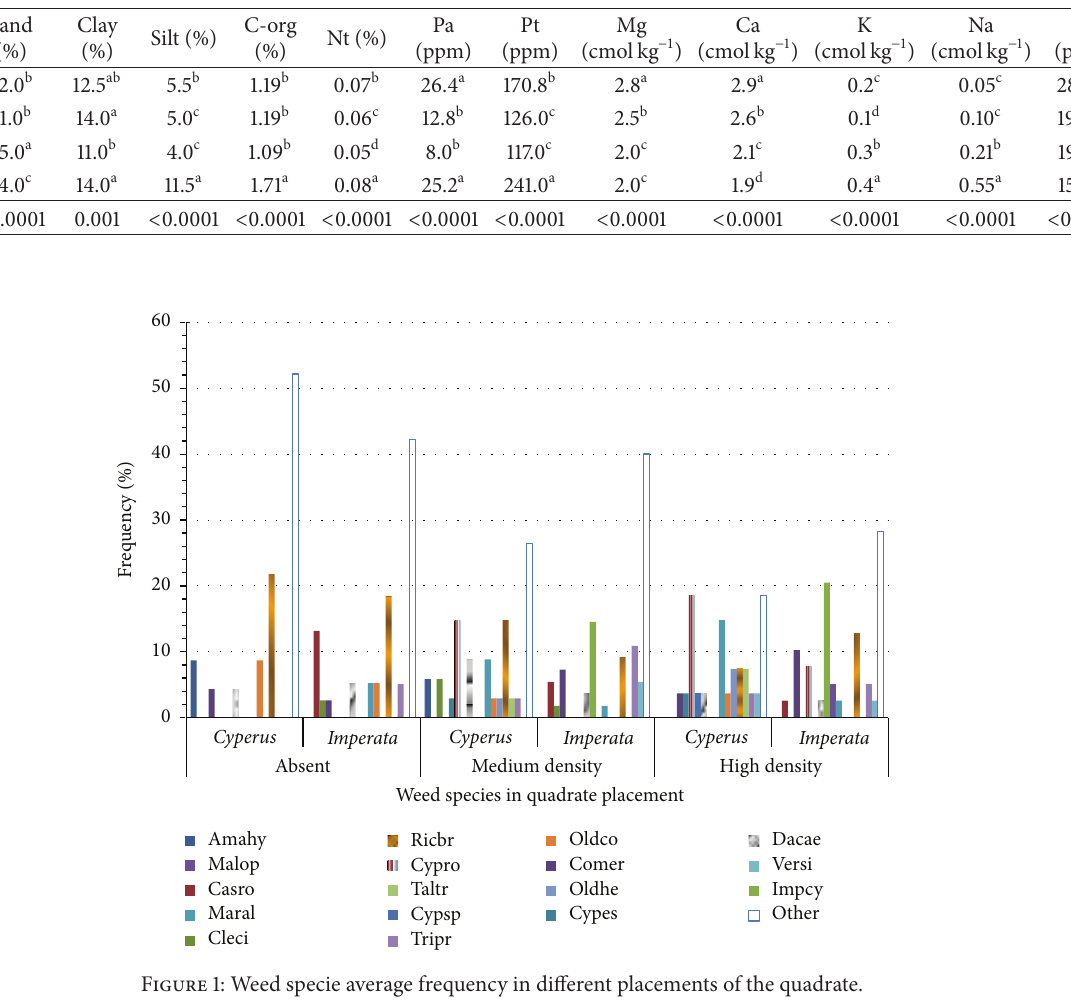
Table 1: Mean values of soil particle sizes and nutrient contents (C, Nt, Pa, Pt, Mg, K, Ca, Na, and Fe) along the toposequence in topsoil (0–20cm).